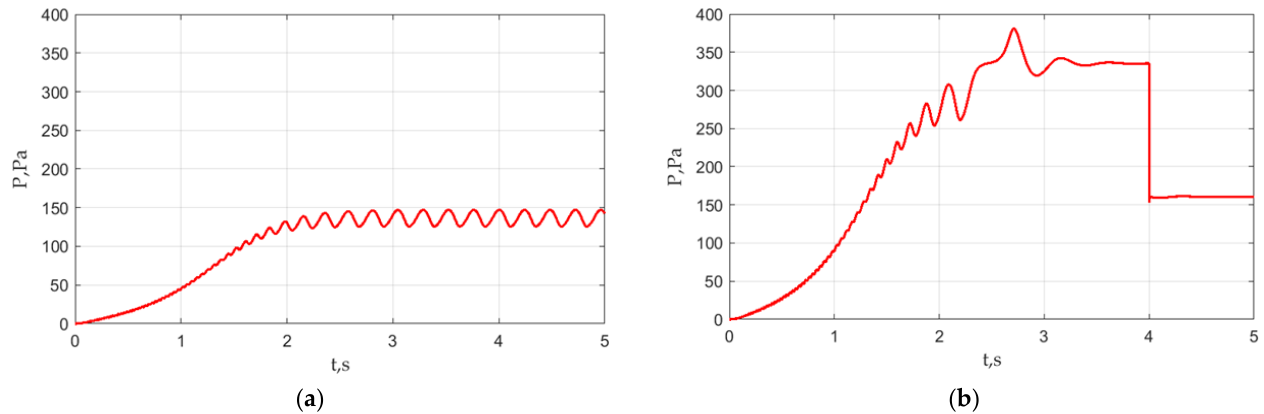
Figure 9. Flow versus time, 380 V: ( a ) Fully open valve; ( b ) fully closed valve.